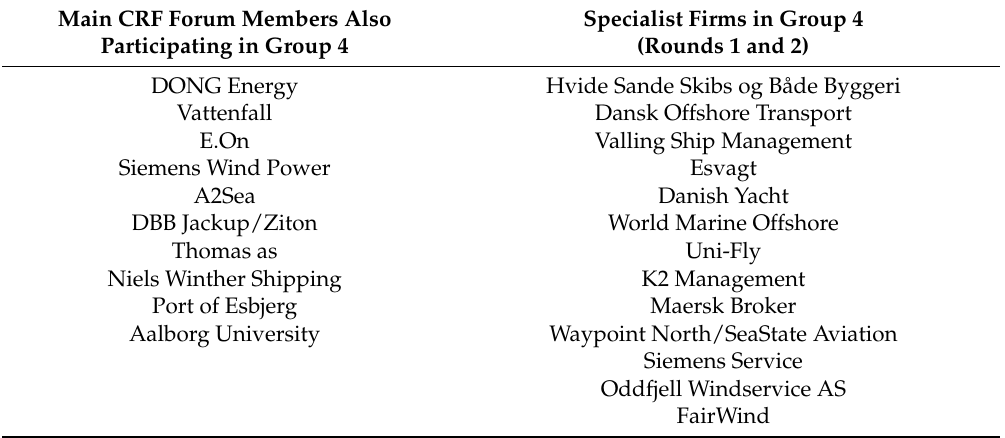
Table 4. Specialized CRF Group 4 O&M logistics member